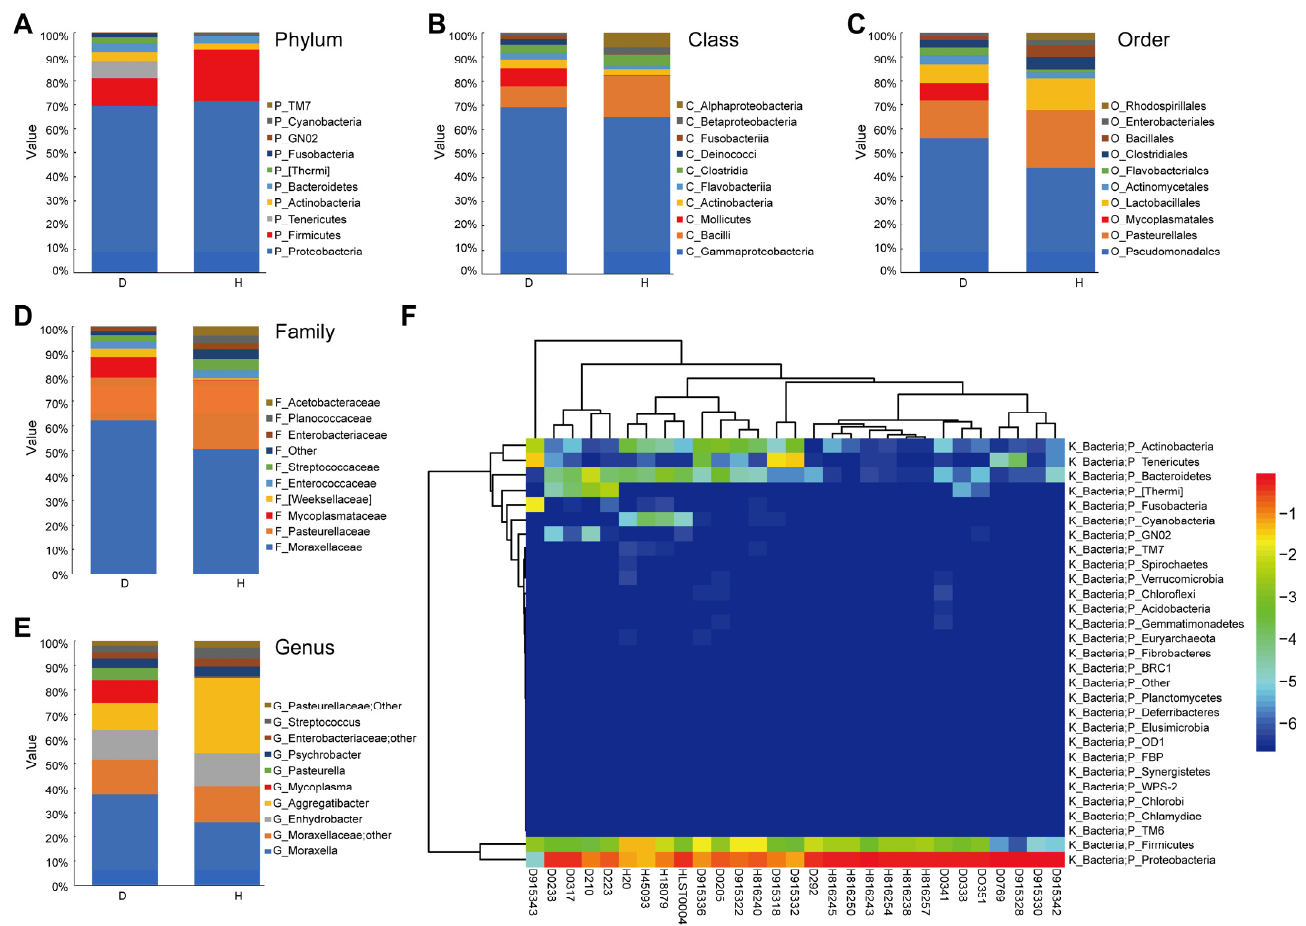
Figure 2. Relative abundance and taxonomic composition in bovine nasal microbial samples. ( A ) Phylum. ( B ) Class. ( C ) Order. ( D ) Family. ( E ) Genus. ( F ) Heat map analysis of the composition of the most abundant microbiota at the phylum level. Horizontal clustering indicates that the abundance of the species in different samples is similar; vertical clustering indicates similar expression levels of all species in different samples. Shorter branch length is associated with a greater similarity. D: bovines with respiratory disease, H: healthy bovines.